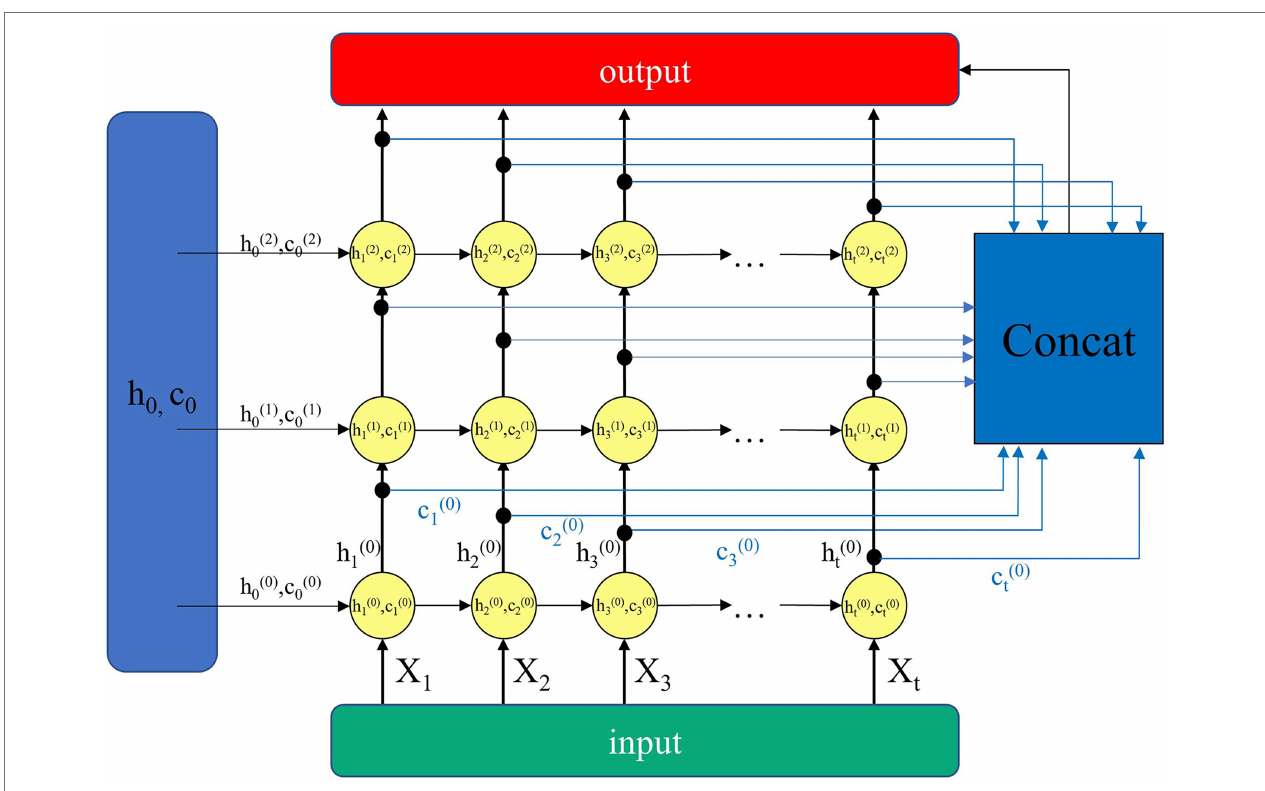
FIGURE 3 | Enhanced LSTM